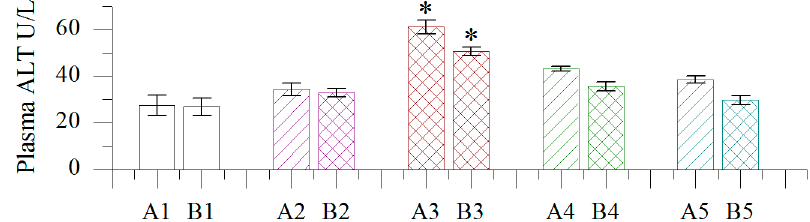
Figure 1. Effect of different concentrations of volatile oil from Blumea balsamifera (BB oil) on plasma ALT levels in rats. 1–5: CK, Olive oil, 100% BB oil, 50% BB oil, 20% BB oil; A, B: normal skin, wound skin; *: Columns labeled by * are significantly different from others by Duncan’s test at p < 0.05.